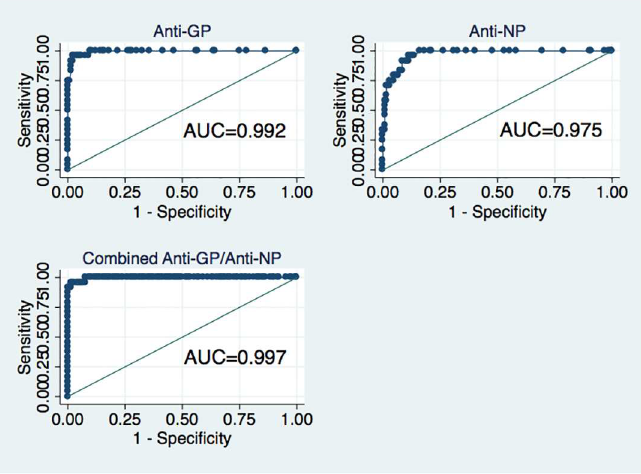
Fig 1. ROC curves for anti-GP, anti-NP, and a combination of the two ELISAs.